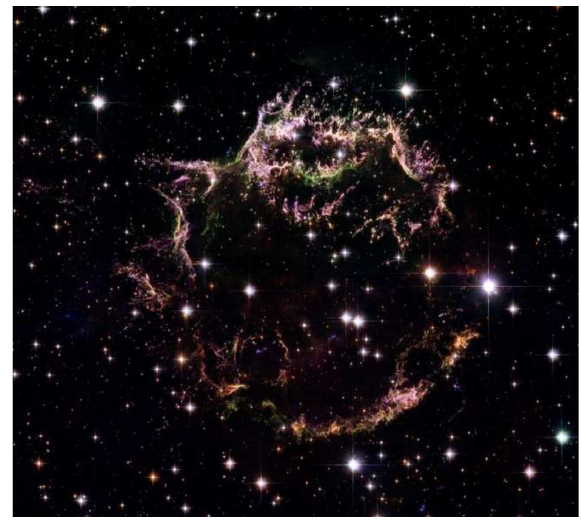
Fig. 2. An example of the processed photometric map. This Hubble Space Telescope (HST) image of the Cas A (proposal 10286) was obtained in several photometric bands in December of 2004. Several simple steps are enough to convert the instrumental units of the image to the physical